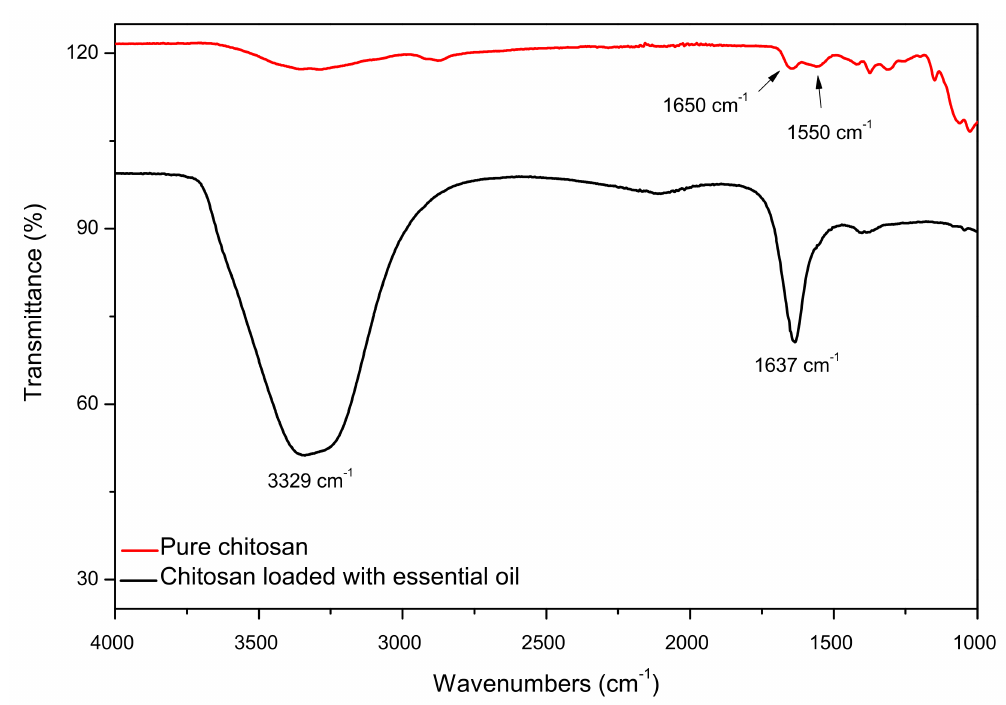
Figure 4. ATR-FTIR spectra of pure chitosan and chitosan loaded with essential oil.